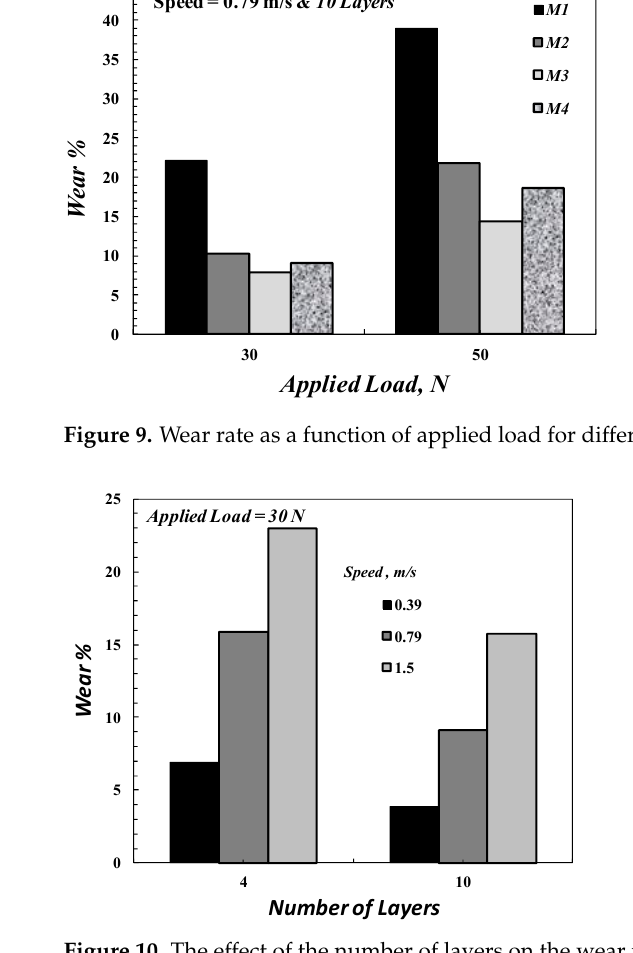
Figure 10. The effect of the number of layers on the wear rate.